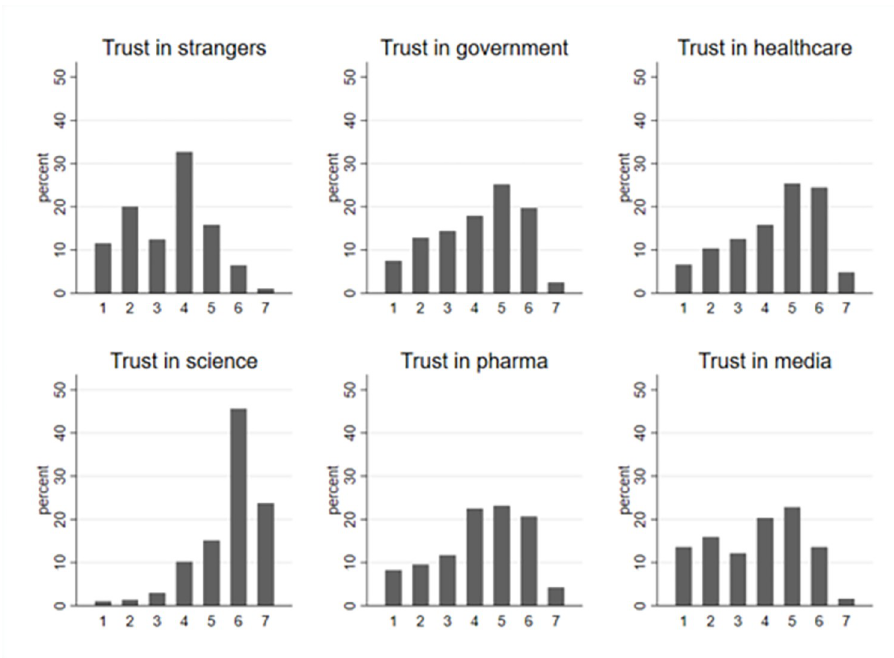
Fig 2. Distribution of responses to trust questions. Note : We ask respondents, how much they trust strangers, government authorities, the healthcare system, science, pharmaceutical companies, and the media. Possible answers are 1 = “Do not trust at all,” 2 = “Do not trust,” 3 = “Somewhat do not trust,” 4 = “Neither trust nor distrust,” 5 = “Somewhat trust,” 6 = “Trust,” 7 = “Trust completely.” This figure shows the distributions of the responses to these